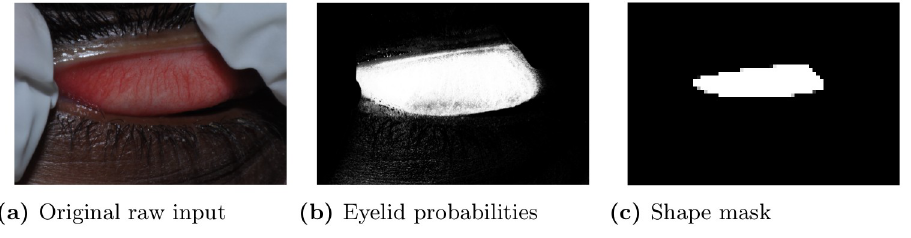
Fig 3. An illustrative example for various eyelid images in our procedural